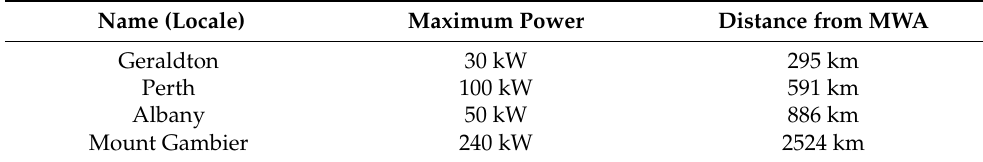
Table 1. Transmitters utilised in this section’s results.